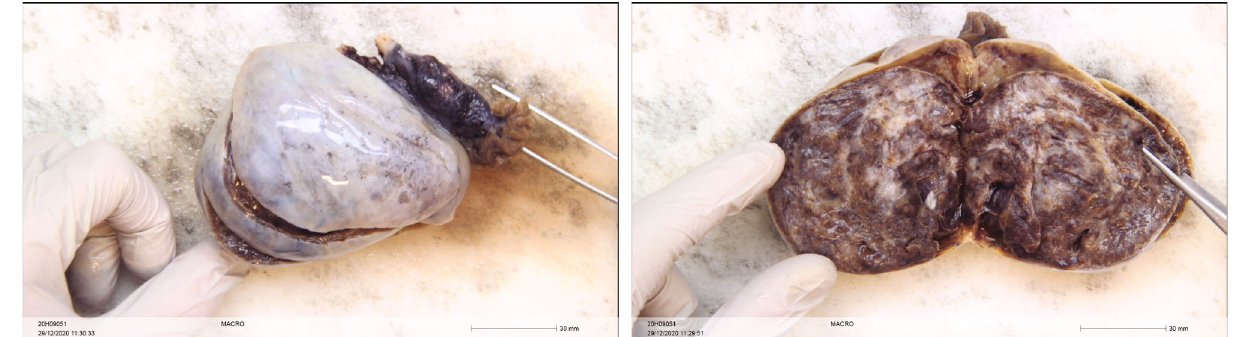
Figure 3: Macroscopic aspect of the tumor. Enlarged ovary replaced by a solid and partially cystic tumor. Solid areas appear yellow- brownish in color with multiple foci of fi brous tissue. Cystic part fi lled with clear yellow fl uid.